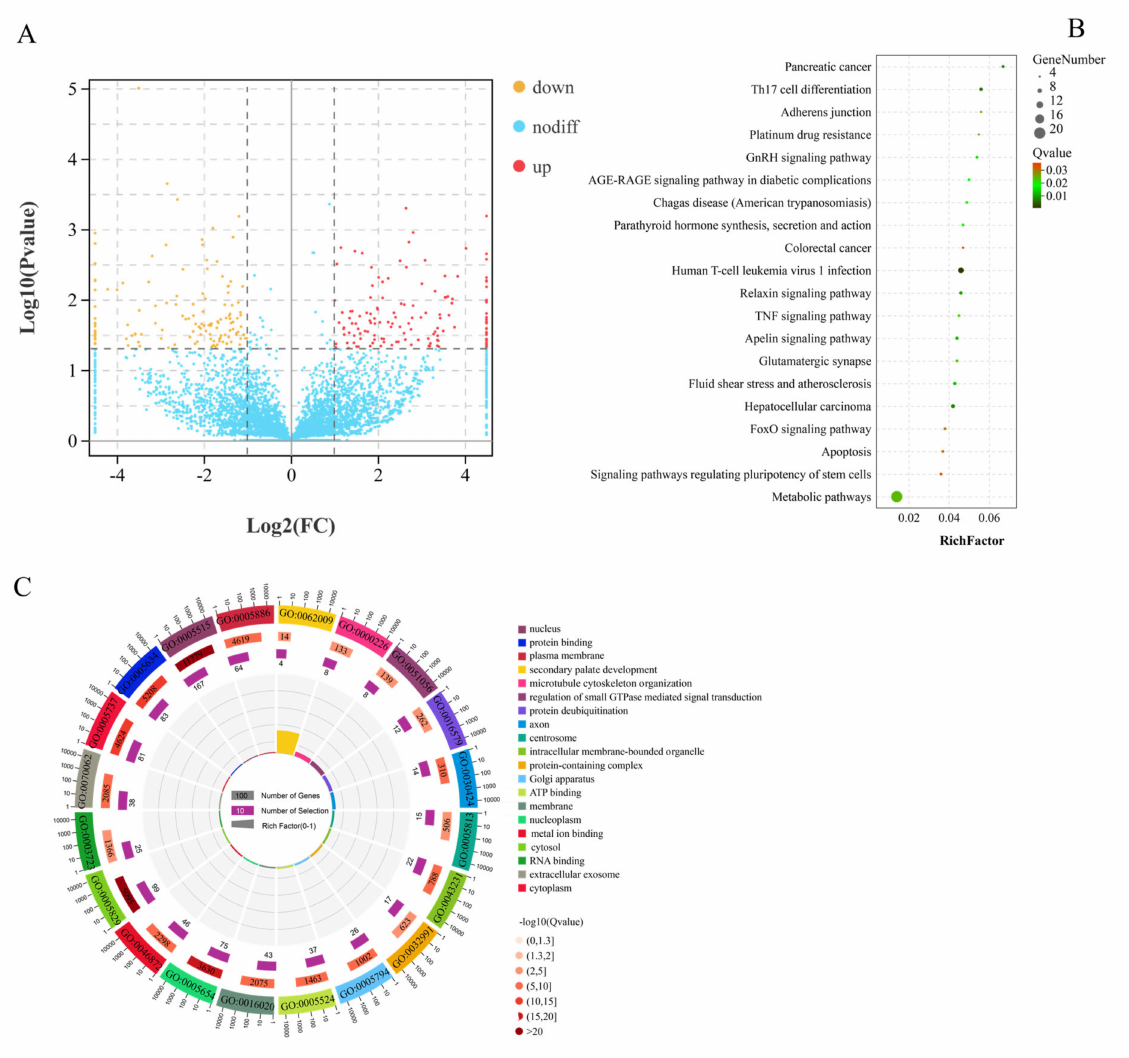
Figure 3. Functional analysis of DEcircRNAs between LFs and SFs of Dazu black goats: ( A ), volcano plot of 290 DEcircRNAs; red represents up-regulated expression and orange represents down-regulated expression; ( B ), top 20 pathways of KEGG enrichment analysis; and ( C ), top 20 terms of GO enrichment